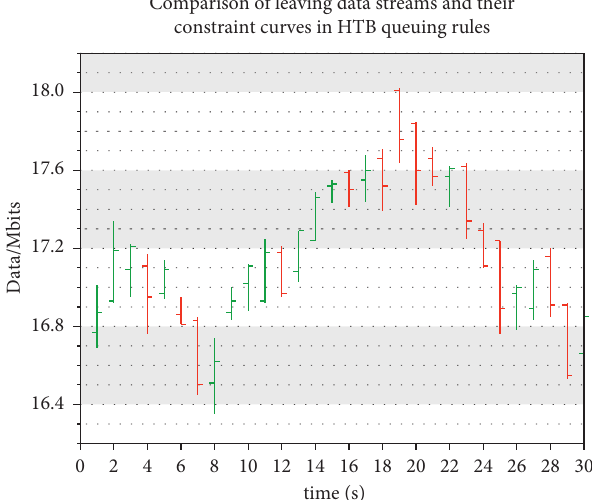
Figure 7: Comparison of leaving data streams and their constraint curves in HTB queuing